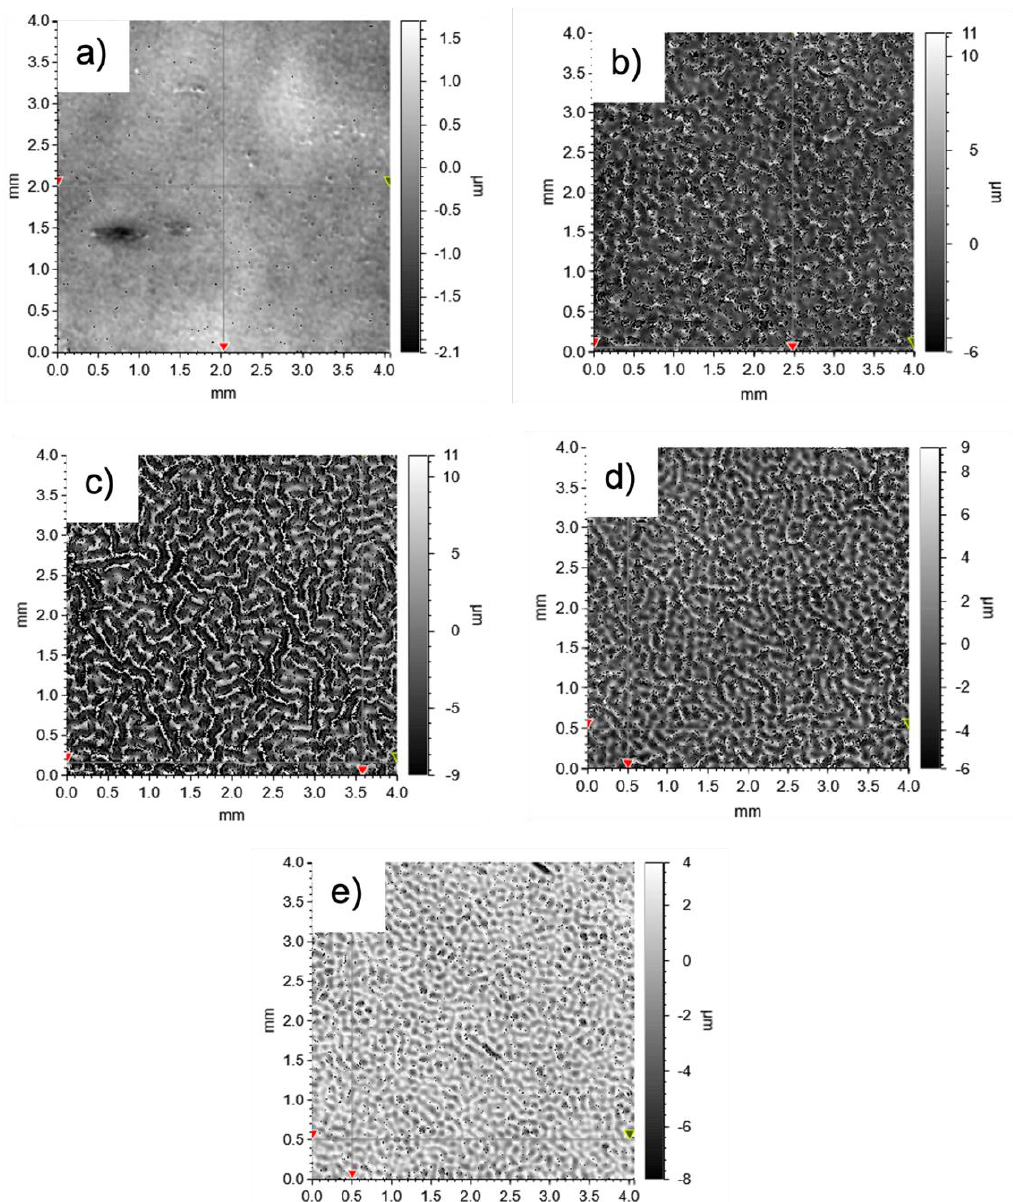
Figure 5. Images obtained by 3D optical profilometry of ( a ) the reference system, and ( b ) 3 wt.%, ( c ) 5 wt.%, ( d ) 7 wt.%, and ( e ) 10 wt.% PBGMA.